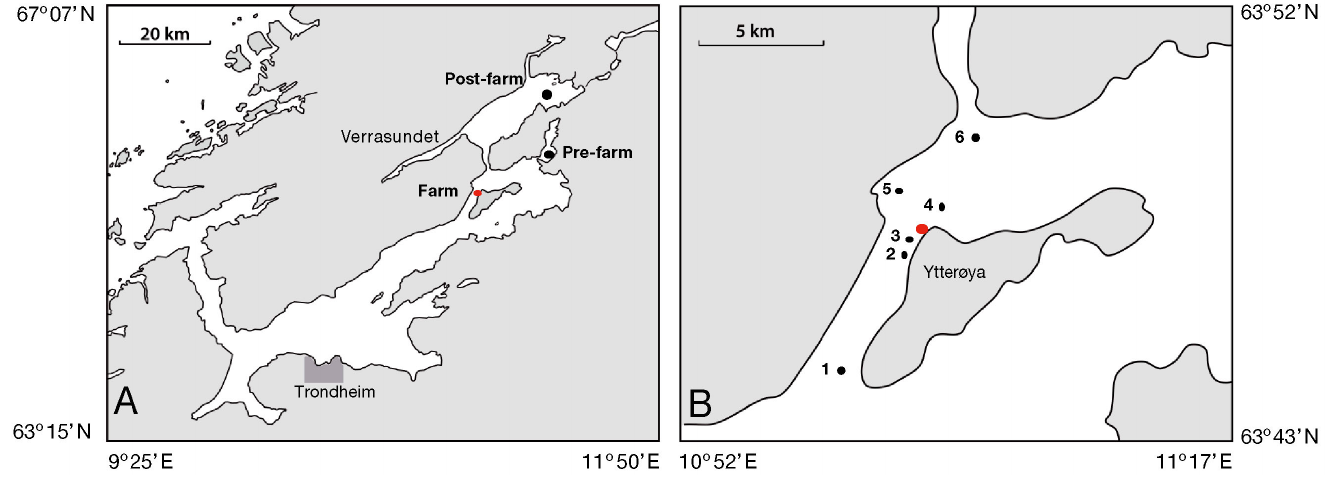
Fig. 1. (A) Locations of pre-farm (sampled in 2005 in Borgenfjorden) and post-farm (sampled in 2013 in Beitstadfjorden) sam- pling sites (black circles) in Trondheimsfjord. The location of the cod farm, near the island of Ytterøya, is indicated by a red cir- cle. Verrasundet, in the innermost part of the fjord is the main wild cod spawning area in Trondheimsfjord. (B) Sampling areas of plankton net hauls for cod eggs (black circles). The downstream and upstream locations are indicated by numbers 1 and 6, respectively; other hauls were taken in the vicinity of the cod farm. See Table 9 for exact coordinates of net